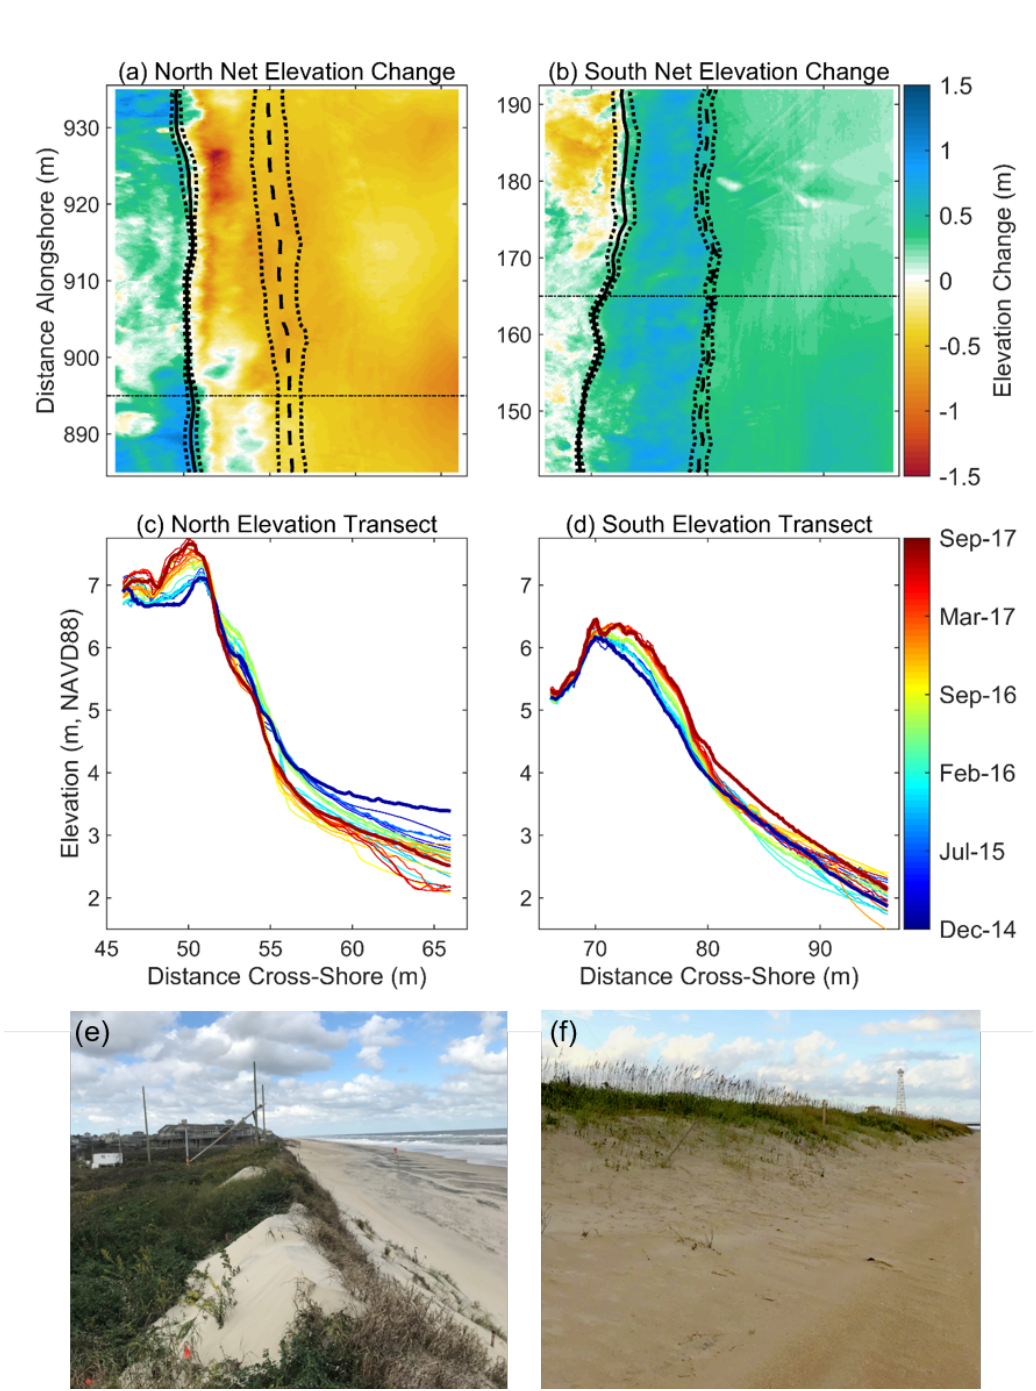
Figure 5. Net morphology change for both sites over the course of the study. ( a , b ) Vertical bare-earth elevation changes (colors at right) at each cross-shore (x) and alongshore (y) grid cell between the first and last surveys for the north and south sites, respectively. The average cross-shore location of the dune crest, x c , and dune toe, x 4 m , are overlain in solid and dashed black lines, respectively, with ± 1 σ for each shown in dotted black lines. ( c , d ) Elevation versus cross-shore distance for each survey (blue to red colors show time) at y = 895m and y = 165m (thin horizontal black lines in ( a , b ) above). ( e , f ) Imagery of the north and south dune field sites from Sep 2017. The two unvegetated sand deposits in ( e ) show the areas of deposition near y = 890 and 930